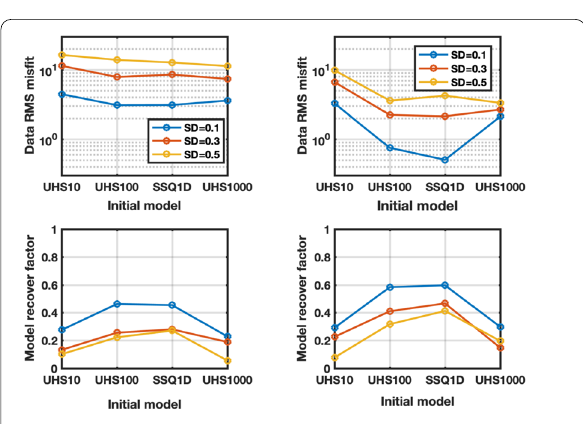
Fig. 12 Data RMS misfits and the model recovery factors of the inverted models shown in Fig. 8 obtained by inverting PTATAN (black), ZLOGA (red), and ZLOGO